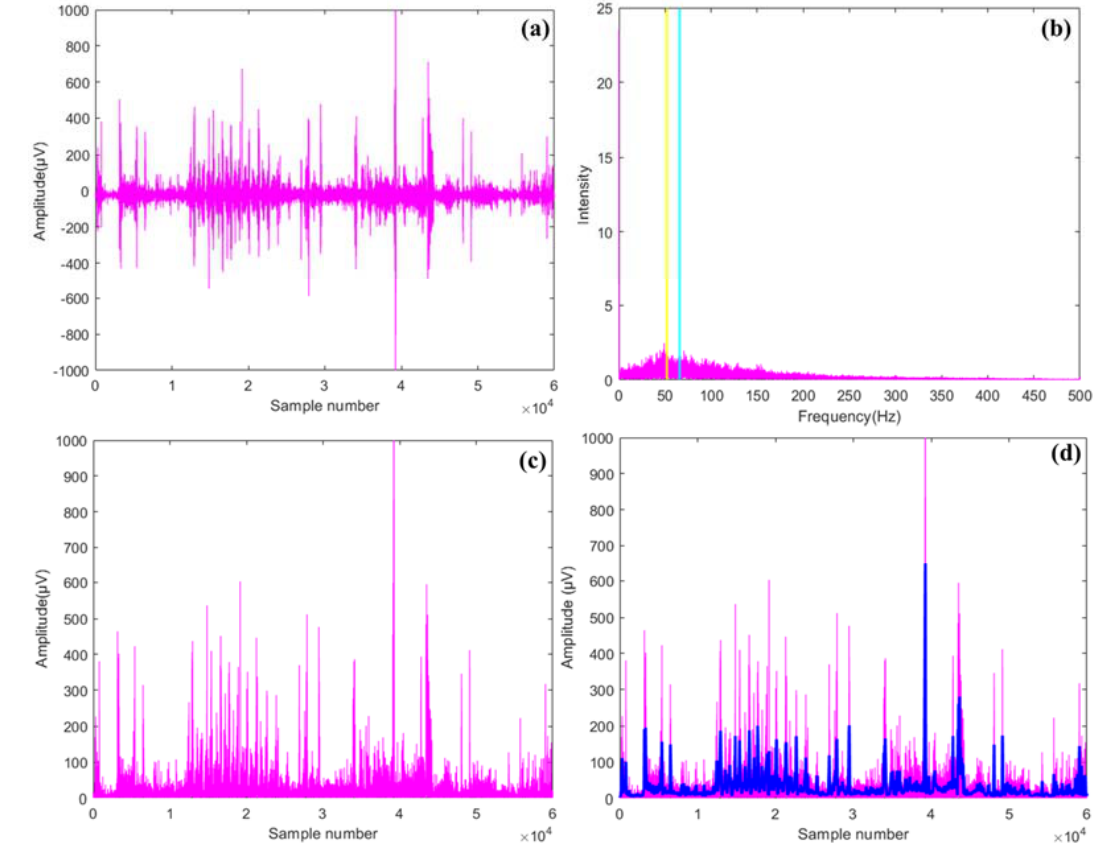
Figure 3. Electromyography derived ( a ) raw signal, ( b ) Fast Fourier Transformation (Cyan bar represents mean frequency [MNF] and Yellow bar represents median frequency [MDF]), ( c ) rectified signal, and ( d ) root mean square envelope in blue color.